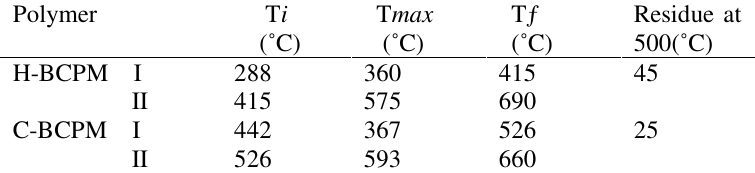
Table 5 . Thermal behaviour of homopolymer and copolymer.